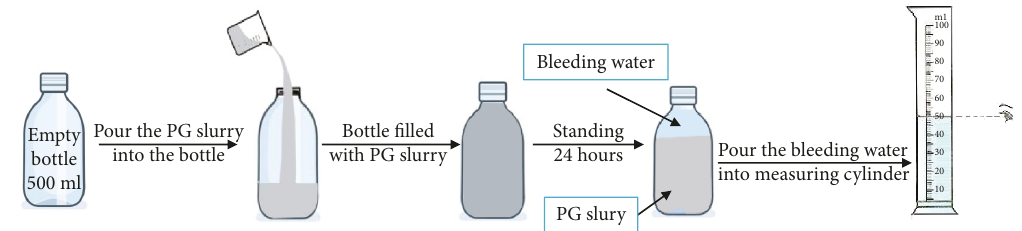
Figure 3: Testing processes of the bleeding rate [25].